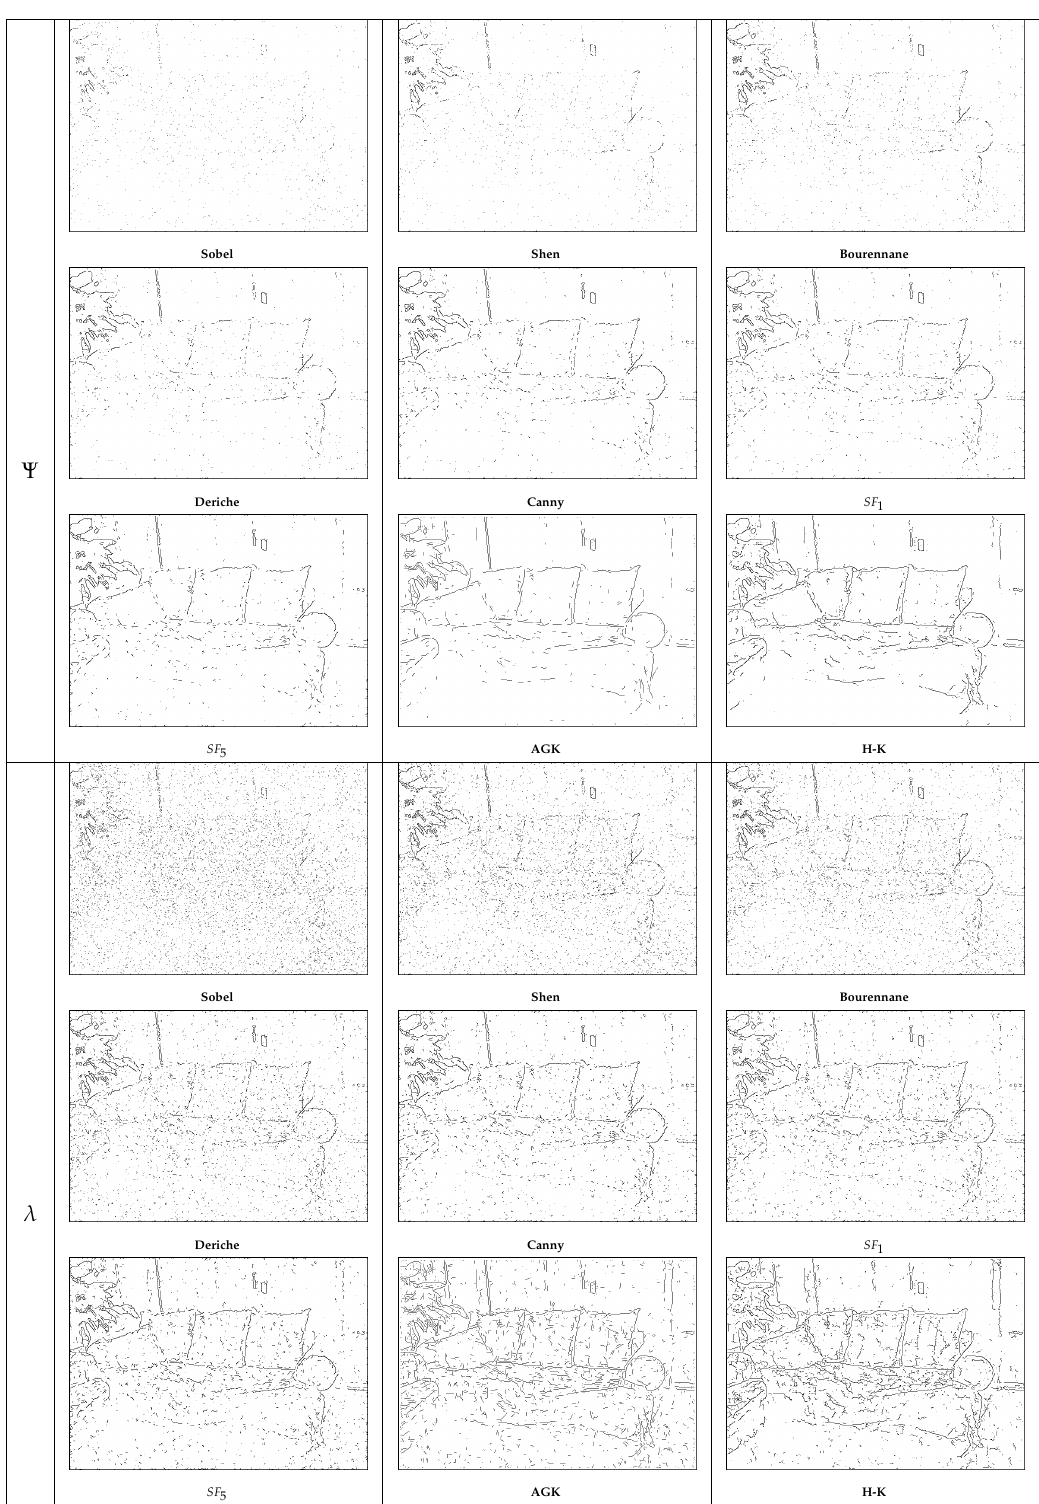
Figure 33. Ideal segmentations for several edge detectors on image 109, PSNR = 14